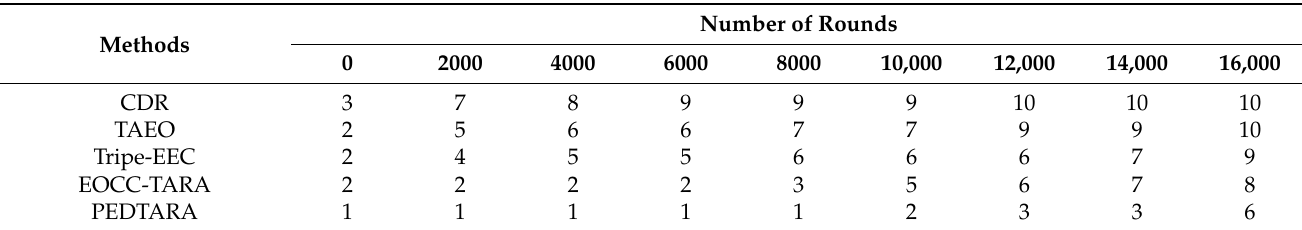
Table 10. Number of dead nodes.